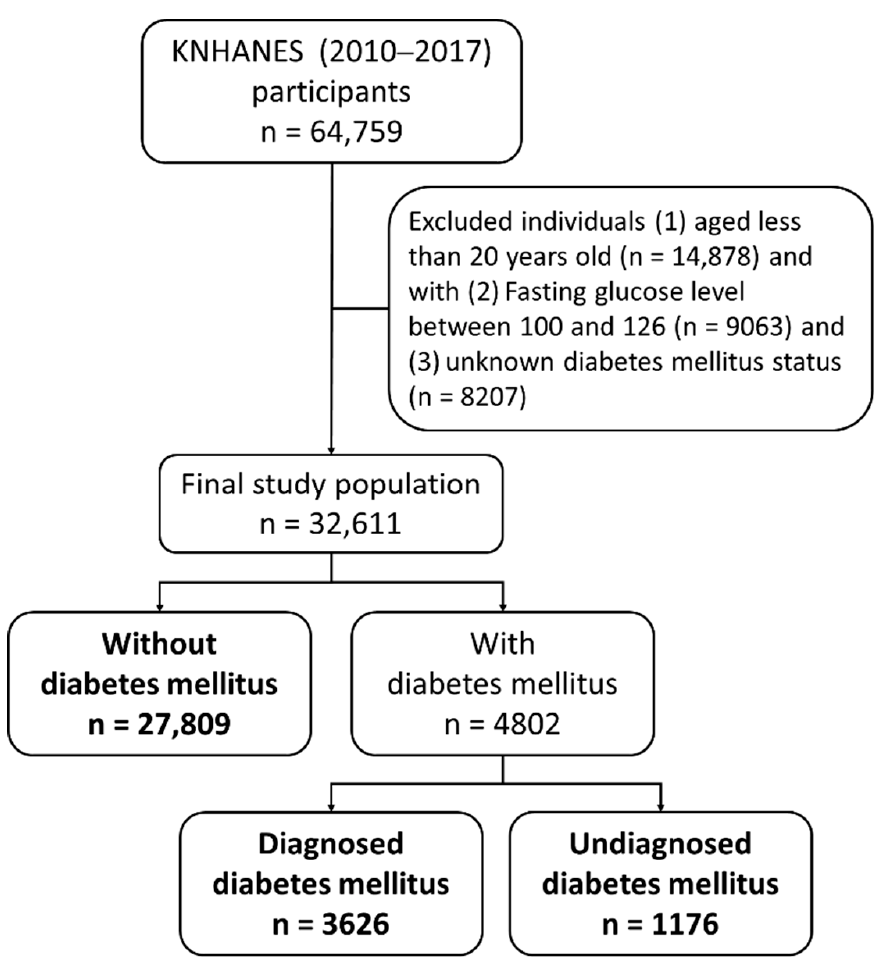
Figure 1. Flowchart presenting the selection of the individuals in the without-diabetes-mellitus (without-DM), with-DM, and undiagnosed-DM (UDM) groups; KNHANES, Korean National Health and Nutrition Examination